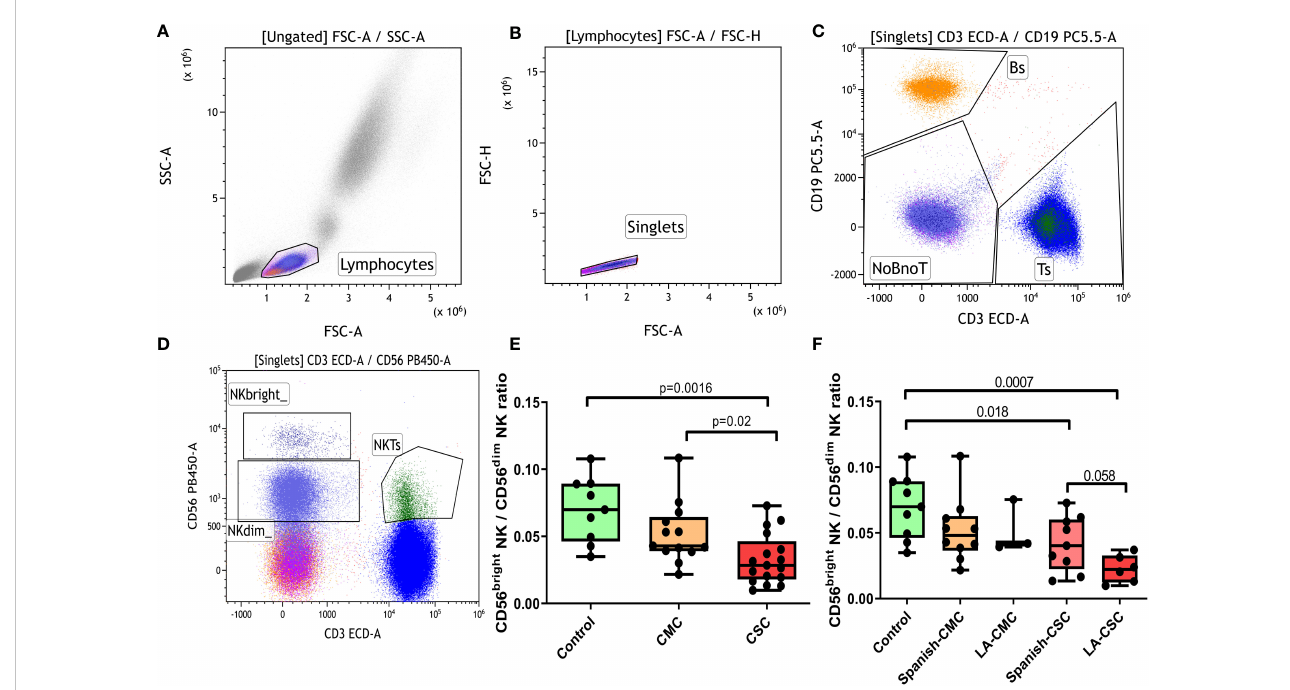
FIGURE 1 Analysis of the CD56 bright NK/CD56 dim NK ratio. (A-D) Overall gating strategy for the selection of T, B and NK populations: (A) Selection of lymphocytes by forward and side scatter. (B) Selection of single events. (C) Gating for T and B populations based on CD3 or CD19 positivity. (D) Selection of T, NK bright , NK dim and NKT populations based on the expression patterns of CD3 and CD56 antigens. (E) CD56 bright NK/CD56 dim NK ratio in controls, CMC and CSC. (F) CD56 bright NK/CD56 dim NK ratio strati fi ed by ethnic origin of the participants. CMC/CSC: convalescent of mild/severe COVID-19 individuals. LA-CSC/CMC: Latin-American convalescent of severe/mild COVID-19. Boxes represent the 25 and 75% quartiles, lines represent the median of the distribution, and whiskers are the maximum and minimum values of the